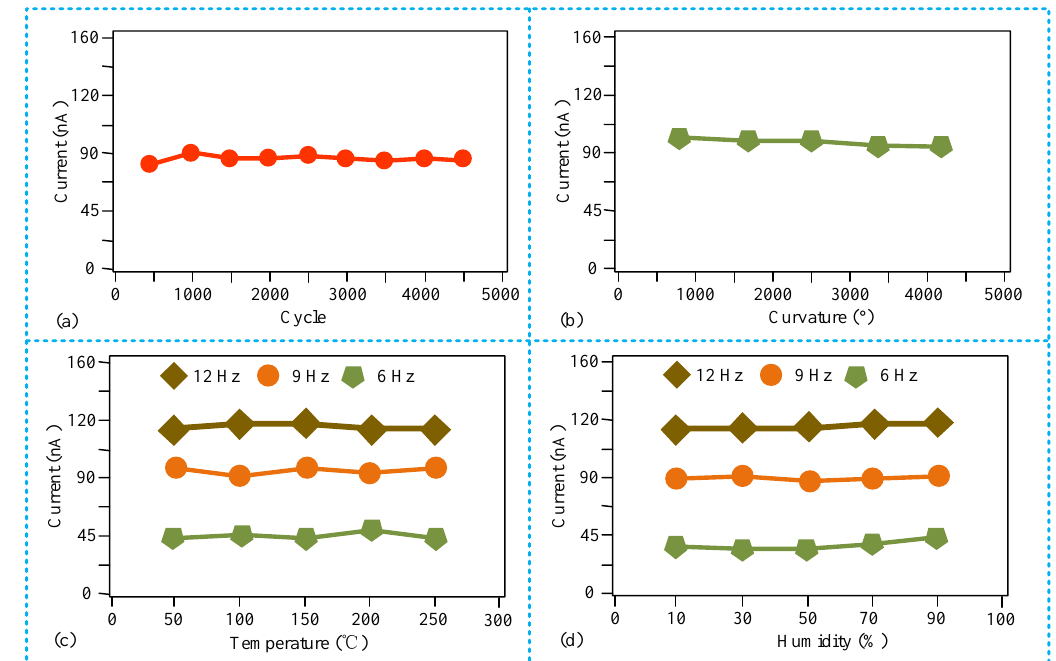
Figure 4. Sensing performance of the RSV − TENG. ( a ) Repeatability tests of the RSV − TENG; ( b ) long-time working tests of the RSV − TENG; ( c ) output performance of the RSV − TENG under different temperatures; and ( d ) output performance of the RSV − TENG under different humidity.